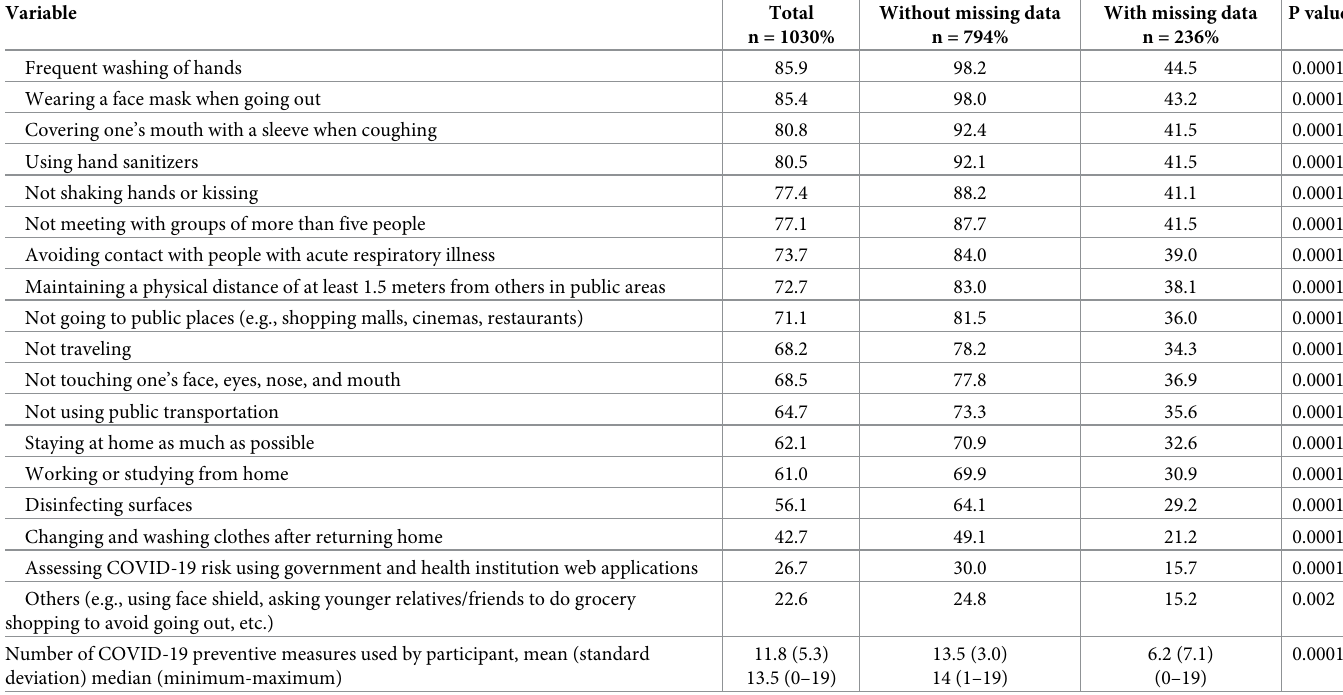
Table 2. COVID-19 preventive